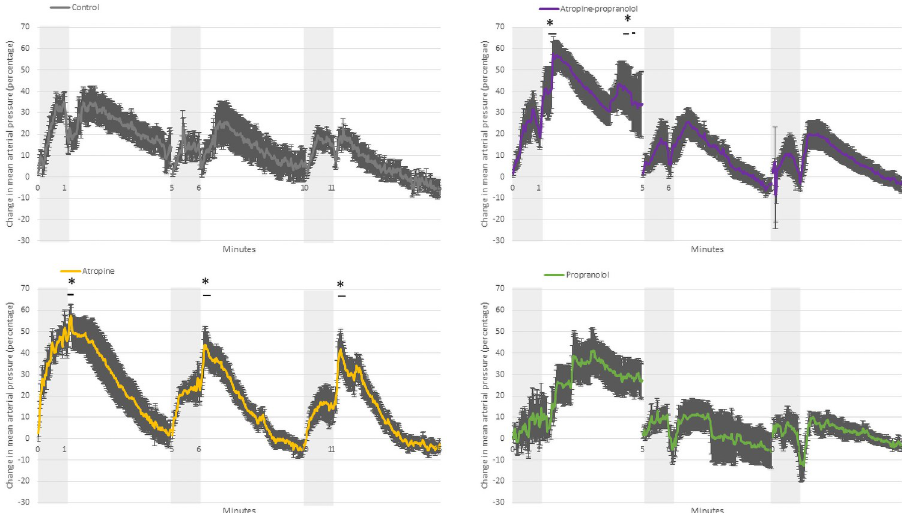
Atropine-propranolol protocol . FHR decreased progressively during UCO (p < 0.0001),